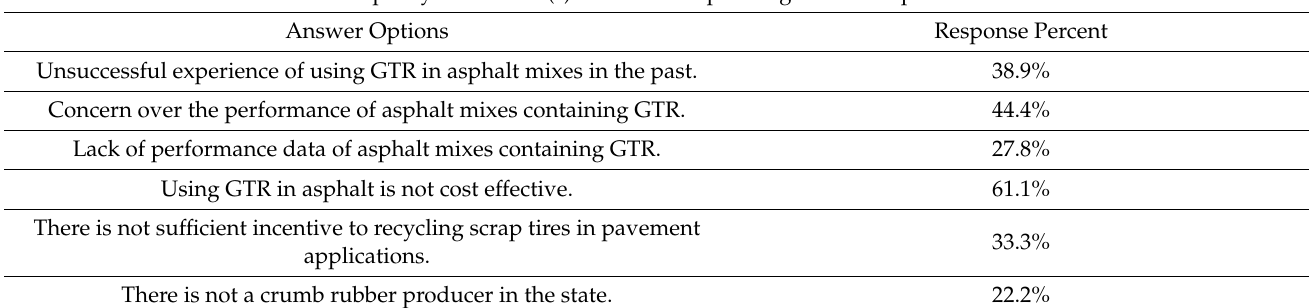
Table 9. Reasons for not using GTR in HMA.